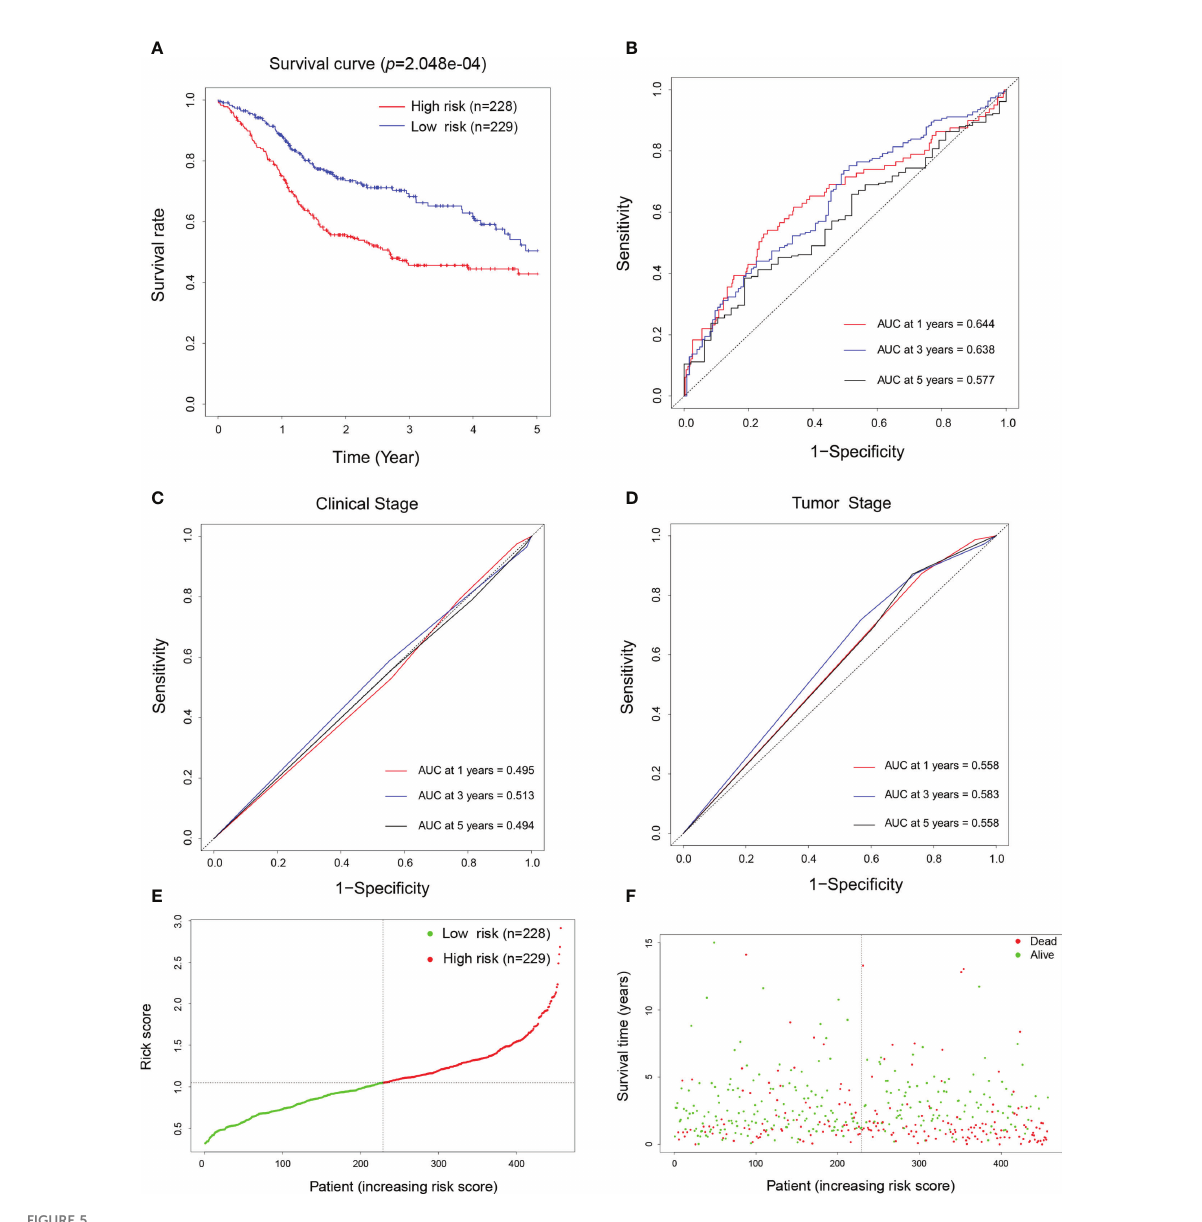
FIGURE 5 Prognostic and prediction model construction of the biomarkers for head and neck squamous cell carcinoma (HNSCC). (A) Overall survival curve of patients with HNSCC depending on their high ( n = 228) and low ( n = 229) risk scores de fi ned by the prognostic model. (B – D) Diagnostic receiver operating characteristic (ROC) curves generated using the risk scores (B) , the TNM clinical staging system (C) , and pathological staging system (D) aiming to predict the 1-, 3-, and 5-year survival of patients with HNSCC. (E) Normalized distribution of the risk scores and the cutoff value for classifying the high- ( red curve , n = 228) and low-risk ( green curve , n = 229) groups. (F) Distribution of the survival status of individual HNSCC patients ( red dots represent dead and green dots represent alive) according to their risk scores ( dashed line represents the cutoff